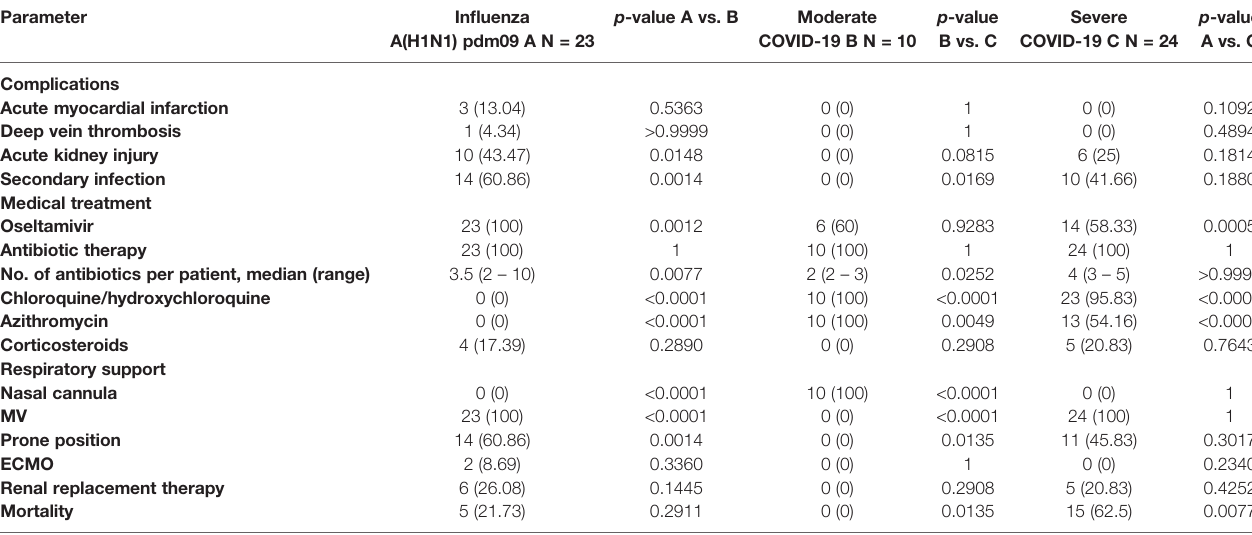
TABLE 3 | Complications and treatment of study participants.